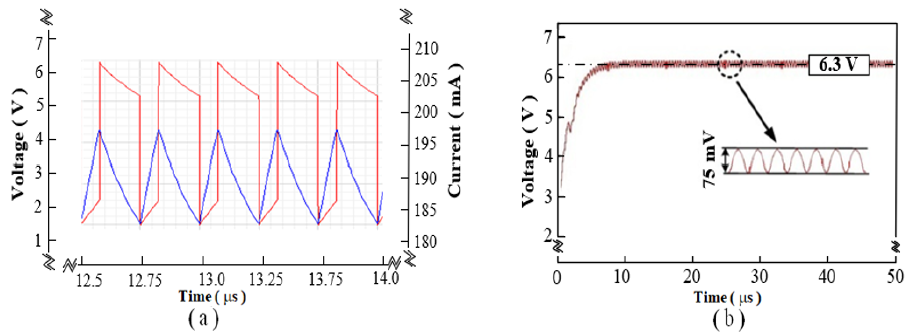
Figure 7. Simulation results: ( a ) output of inductor current I L (blue) and voltage V L (red) after inductor; ( b ) output voltage.